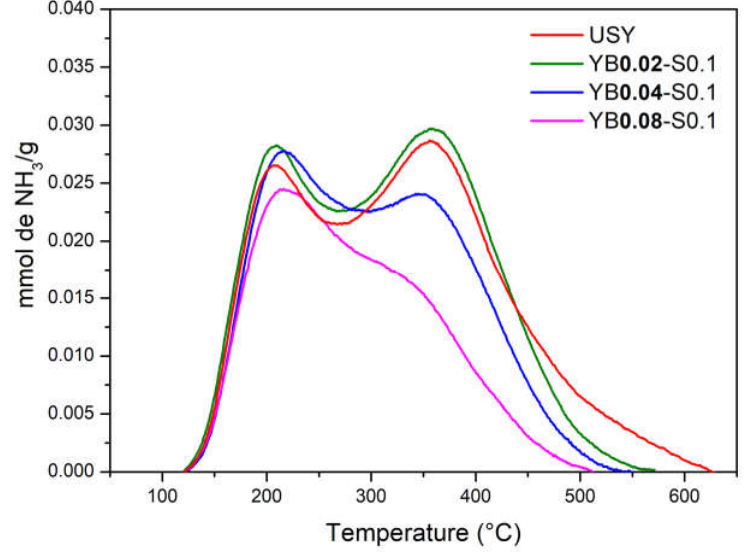
Figure 12. TPD-NH 3 profiles of the calcined original zeolite and the zeolites produced using different base concentrations.